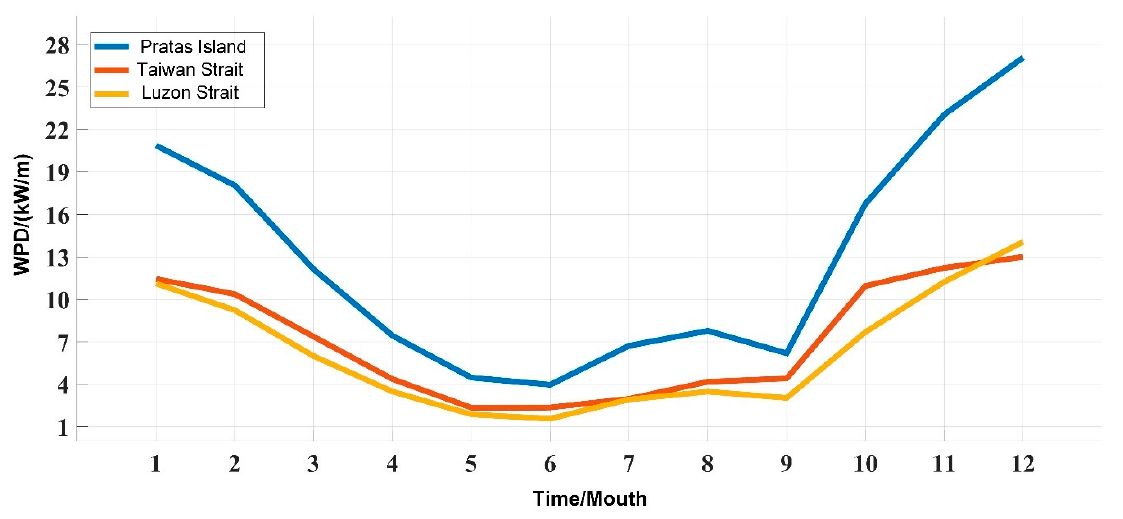
Figure 11. Comparison of monthly WPD values from January to December in dominant sea area. Table 2. Statistics of developable months of WPD in dominant sea areas. Pratas Island Taiwan Strait Luzon Strait